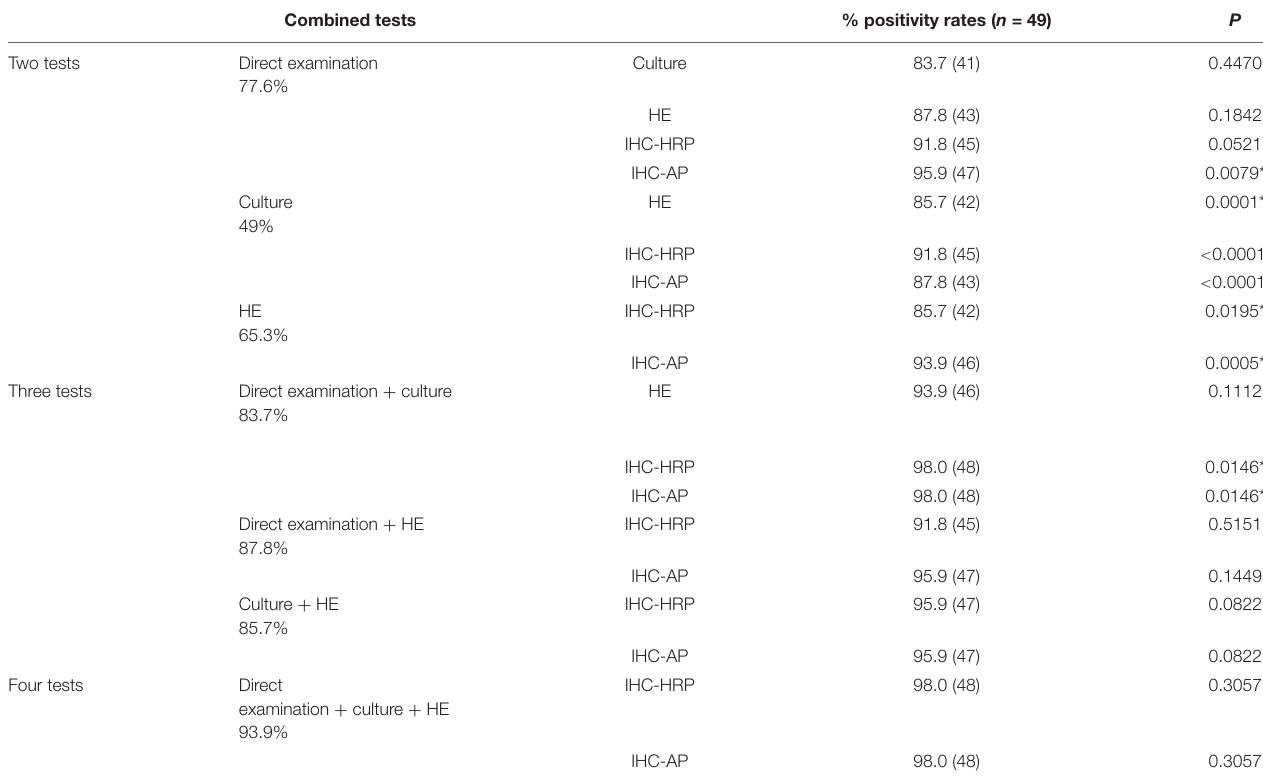
TABLE 2 | Positivity rates obtained by combining diagnostic test